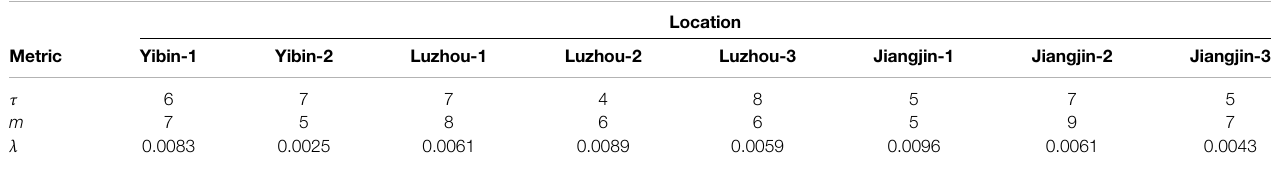
TABLE 3 | Summary of the data reconstruction.